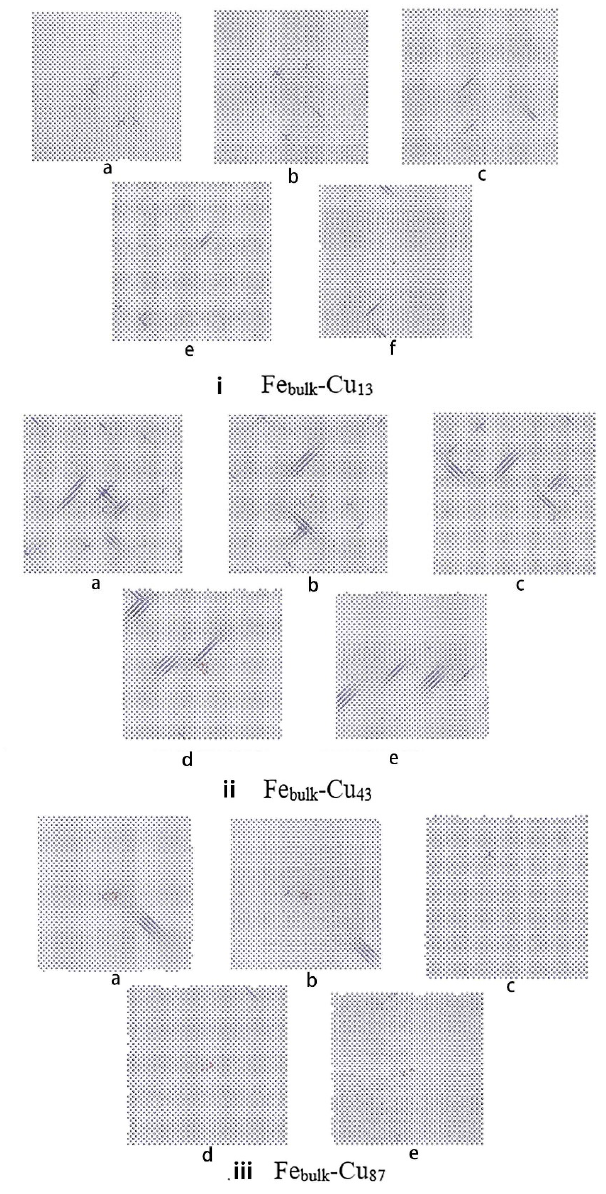
Figure 5. Two-dimensional projection of the Fe bulk –Cu n system, n = 13 ( i ), 43 ( ii ) and 87 ( iii ): (a) 400 K; Figure 5. Two ‐ dimensional projection of the Fe bulk –Cu n system, n = 13(i), 43(ii) and 87(iii).: ( a ) 400 (b) 500 K; (c)600 K; (d) 800 K; (e) 900 K; ( b ) 500 K; ( c )600 K; ( d ) 800 K; ( e ) 900 K.